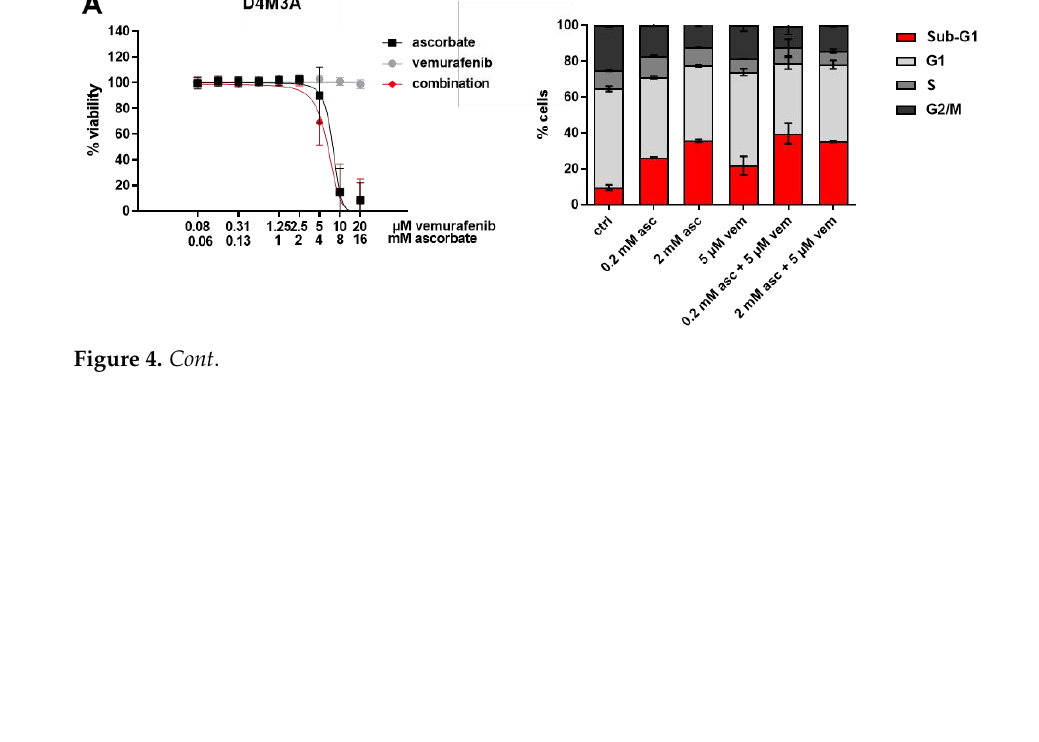
Figure 4. Effects of ascorbate and vemurafenib on viability, cell cycle, protein expression and long- term growth of BRAF mutated mouse melanoma cells D4M.3A. ( A ) D4M.3A cells were treated with ascorbate, vemurafenib, and their combination. Viability of treated cells was measured and com- pared to the untreated control. Shown are the mean values with standard deviations of three inde- pendent experiments, each measured in quadruplicates and normalized to the untreated control. ( B ) D4M.3A cells were treated with ascorbate, vemurafenib, and their combination. After propidium iodide staining, the cell cycle was measured by flow cytometry. Shown are the mean values of each cell cycle fraction with standard deviations of three independent experiments, each measured in triplicates. ( C ) Protein expression levels of Hif-1α, Glut-1, Svct1, Svct2, phospho-Erk1/2 (pErk), Erk1/2 (Erk), Pcna, and β-Actin as control were analyzed by Western Blot in the cell line D4M.3A after treatment with ascorbate, vemurafenib, and their combination. Shown is one representative experiment of three. ( D ) For a colony formation assay D4M.3A cells were treated with ascorbate, vemurafenib and the combination. The growth area of the formed colonies was measured and nor- malized to the surface area of the culture dish (100%). ( E ) Quantification of the colony formation assay shown in ( D ). D4M.3A cells were treated with ascorbate, vemurafenib and the combination. *: p ≤ 0.05; ****: p ≤ 0.0001. 3.4. Effects of Ascorbate and Vemurafenib In Vivo To assess the treatment efficacy in vivo, a C57BL/6NCrl mouse model was used to subcutaneously inject the isogenic murine melanoma cell line D4M.3A. Once the tumors were established, the animals were randomized into four groups (14 in the control group and eight in each treatment group), and treatment was initiated. Mice of all treatment